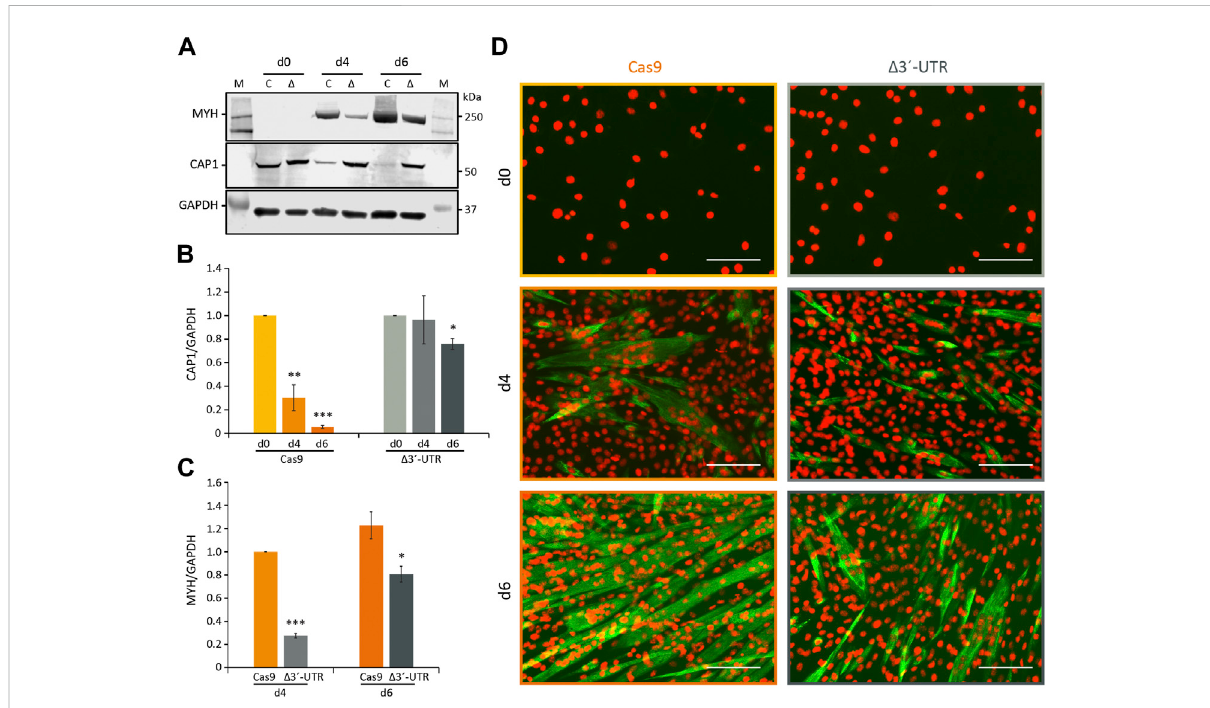
FIGURE 6 Requirementofthe3 ′ -UTRfor Cap1 regulationduringmyogenesis. (A) The3 ′ -UTRof Cap1 wasdeletedinC2C12cellsusingCRISPR/Cas9. Δ 3 ′ - UTR ( Δ ) and Cas9-only (C) control cells were differentiated for the indicated times. Representative immunoblots for MYH and CAP1 are shown. (B) Quanti fi cationofCAP1proteinatday0,day4andday6ofdifferentiationnormalizedtoday0. (C) Quanti fi cationofMYH,normalizedtoCas9control cells at day 4. (D) Immuno fl uorescence staining (×20) of C2C12 cells stained with MYH (green) and DAPI (orange) after differentiation for 4 and 6 days (d4 and d6), in comparison to undifferentiated control cells (d0). Thick and multinucleated myotubes are reduced in the Δ 3 ′ -UTR cells (right panel) at day 6 of differentiation, compared to the Cas9 control (left panel). Error bars, SEM ( n = 3); * p < 0.05, ** p < 0.01, *** p < 0.001 (Student ’ s t -test). Scale bar, 200 μ